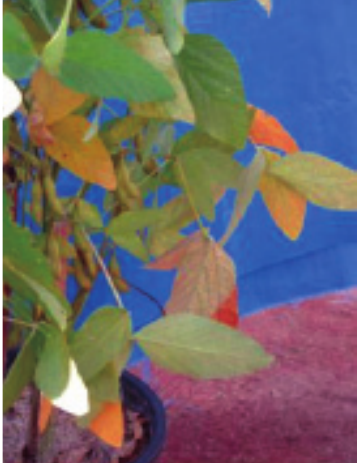
Figura 4. Detalhe de folhas de soja com deficiência de P. Notam-se os sintomas de colapso do pecíolo e arroxeamento de folhas e